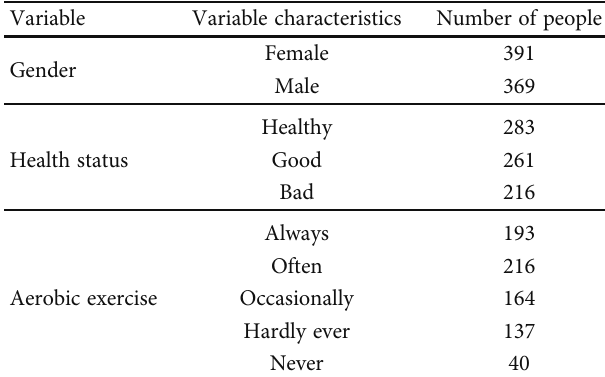
Figure 1: Graph of the association between aerobic exercise and physical and mental health. Table 2: Distribution of subjects ’ basic